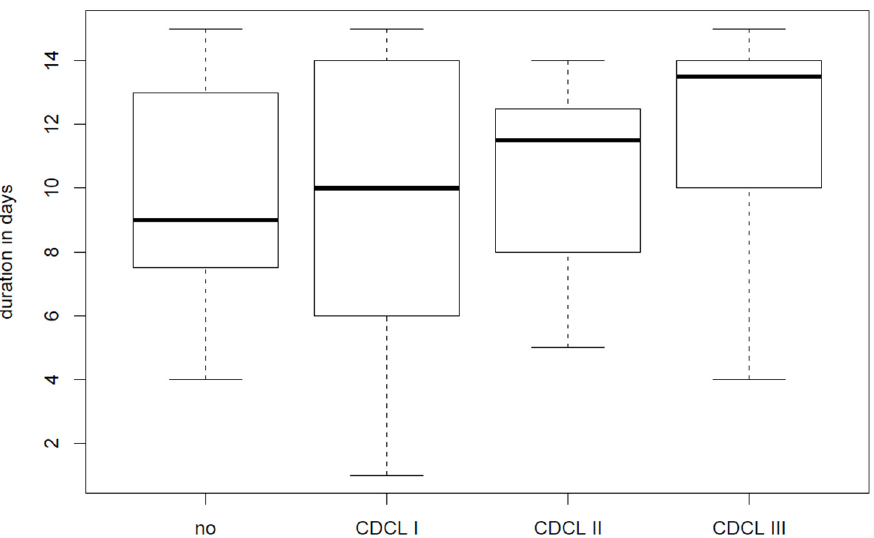
Figure 1. The box plots show the relationship of the median (bold black horizontal lines in box, which represents the interquartile range) drain indwelling time (=time-to-drain removal) and the increasing degrees of complications classified by the Clavien–Dindo Classification (CDCL). Patients with no complications had their drains removed at day 9 (5.5), CDCL I patients at day 10 (8), CDCL II patients at day 12 (3.75) and CDCL III patients at day 14 (3). Data are depicted as median (interquartile range).